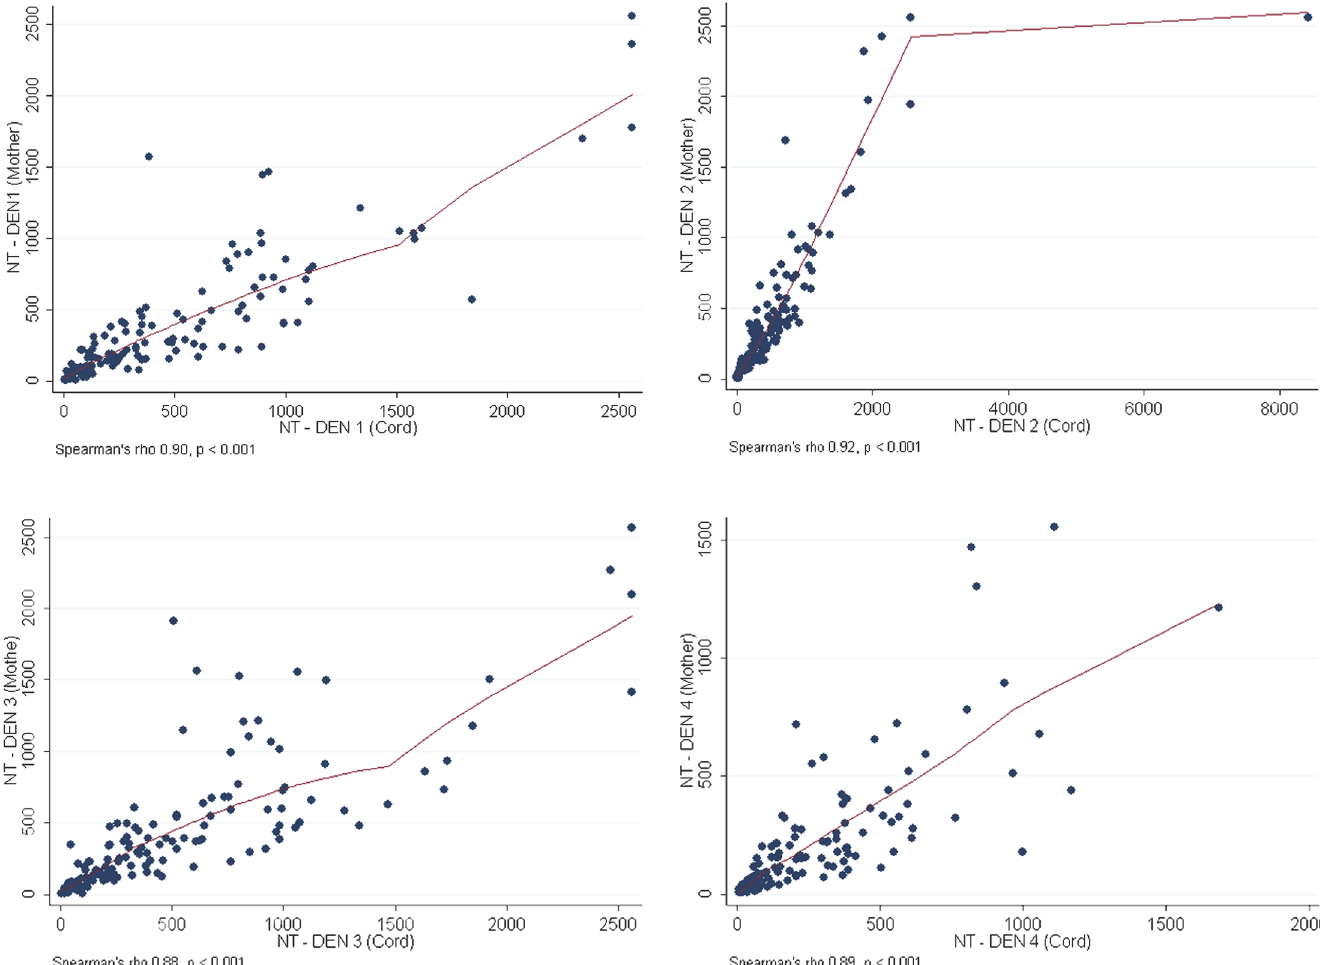
Fig 1. Correlation between maternal and cord blood of DEN-1 to DEN-4 neutralizing antibodies titers. X-axis shows GMTs of cord blood dengue antibody and Y-axis shows GMTs of maternal dengue antibody of DEN-1, DEN-2, DEN-3 and DEN-4. The Spearman ’ s rho of DEN1, DEN2, DEN3 and DEN4 are 0.90, 0.92, 0.88 and 0.89